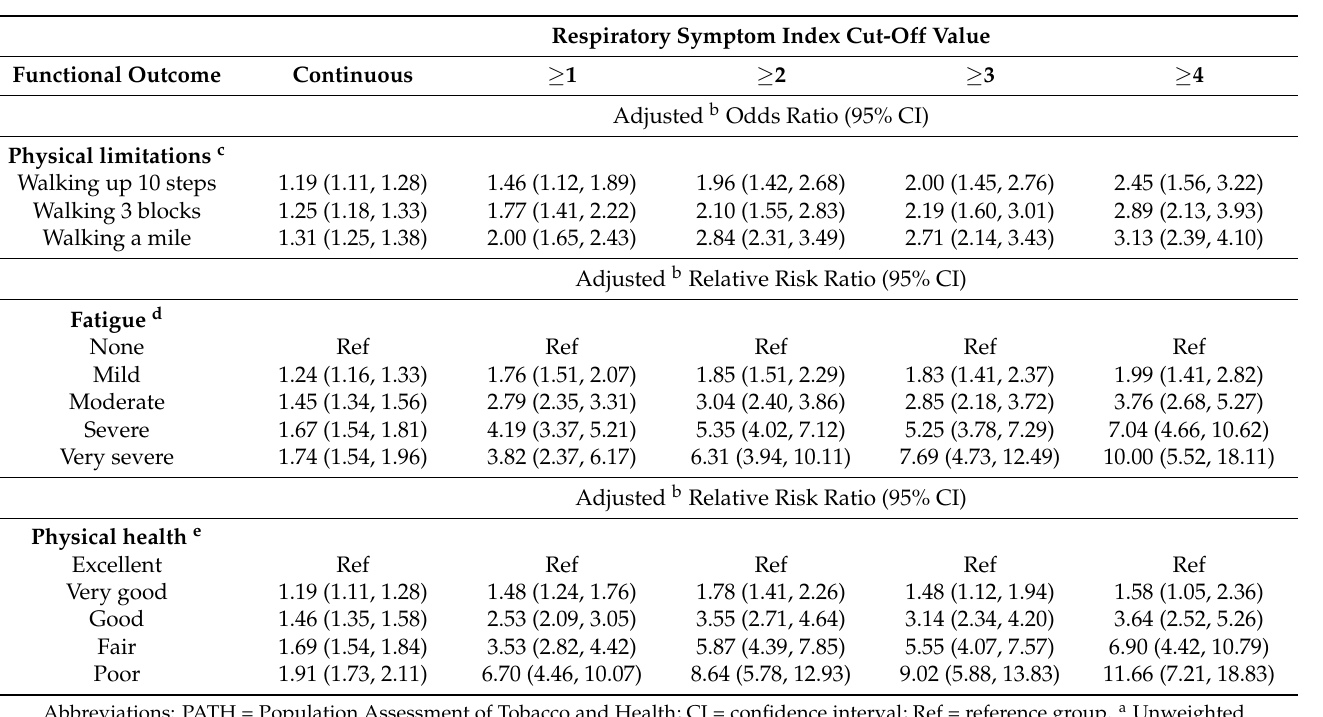
Figure 3. Weighted relationship between respiratory symptoms index score and functional outcomes, Wave 2 (2014–2015) of the Population Assessment of Tobacco and Health (PATH) Study. PATH Study functional outcomes illustrated in the figure: Does your health limit you in any of the following activities? Walking three blocks. (Unweighted n = 16,263). In the past 7 days, how would you rate your fatigue on average? By fatigue, we mean feeling unrested or overly tired during the day, no matter how many hours of sleep you have had. (Unweighted n = 16,284). In general, how would you rate your physical health? (Unweighted n = 16,291). Table 4. Weighted association between functionally important respiratory symptoms and functional outcomes, Wave 2 (2014–2015) of the PATH Study.